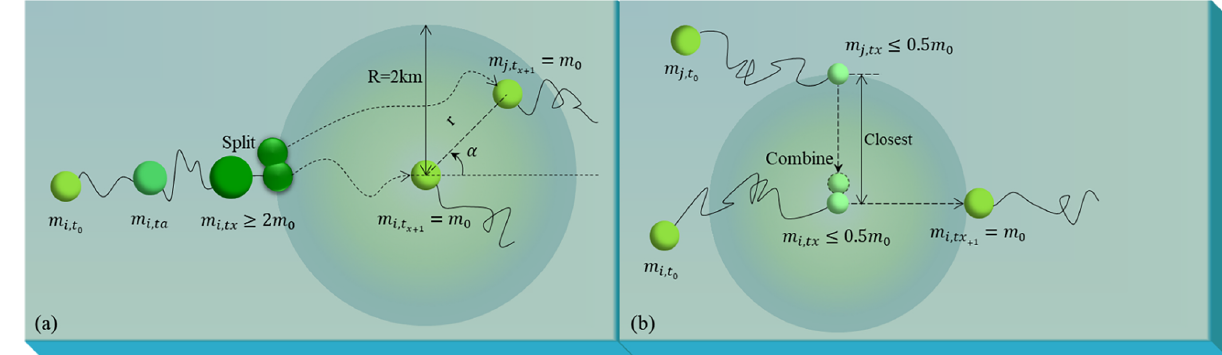
Figure 2. Diagram of the replication (a) and extinction (b) process of simulated macroalgae represented by